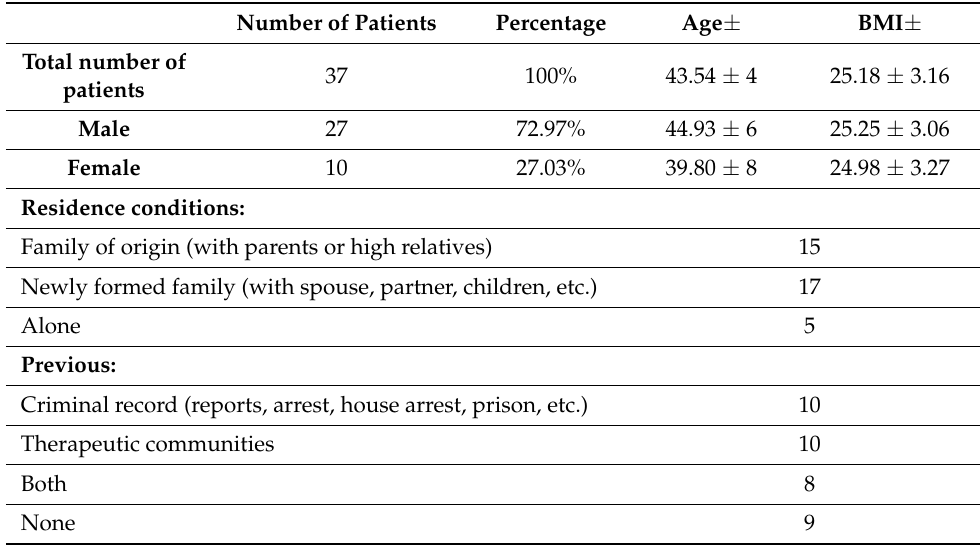
Table 6. Socio-demographic characteristics of the patients.